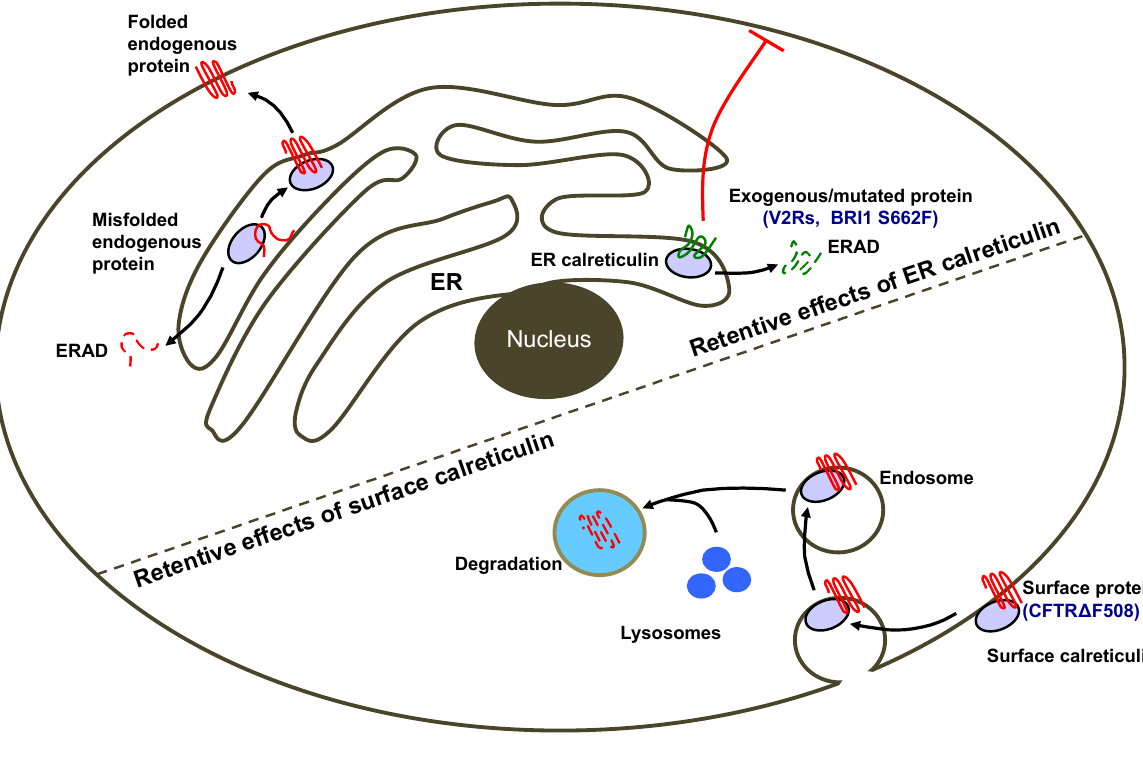
Figure 2. Mechanisms for calreticulin-mediated inhibition of cell surface protein localization. Calreticulin in the ER can trap misfolded endogenous proteins and exogenous/mutated proteins, preventing them to be exported to the cell surface and target them to ERAD (ER-associated degradation). In addition, calreticulin in post-ER compartments can facilitate the internalization of proteins into endosomes, inhibiting their recycling and promoting degradation, thus removing them from the cell surface